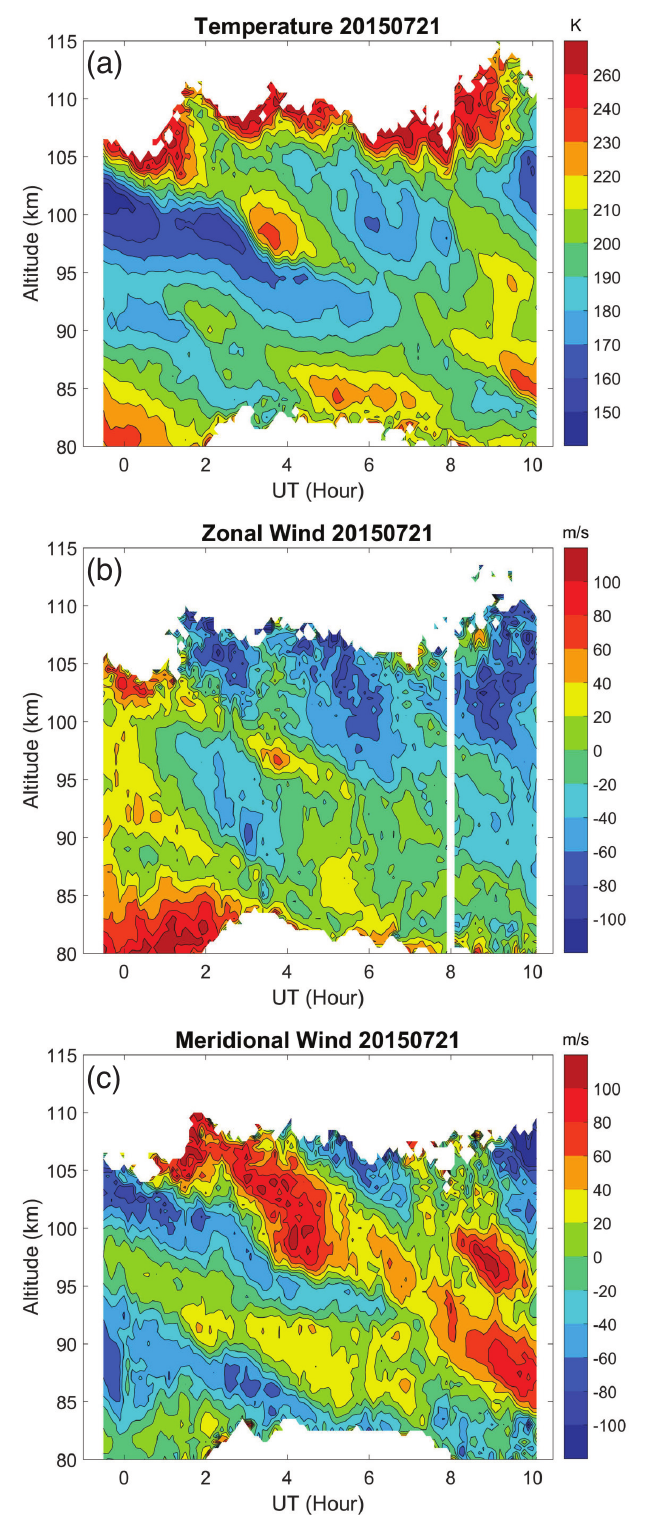
Figure 2. Lidar measurements taken on 21 July 2015 of ( a ) temperature, ( b ) zonal wind, and ( c ) meridional wind over ALO in Cerro Pachón, Chile. Note the nonlinear contour scale (at lowest altitudes) is used to highlight the low sensitivity of the Na winds in the